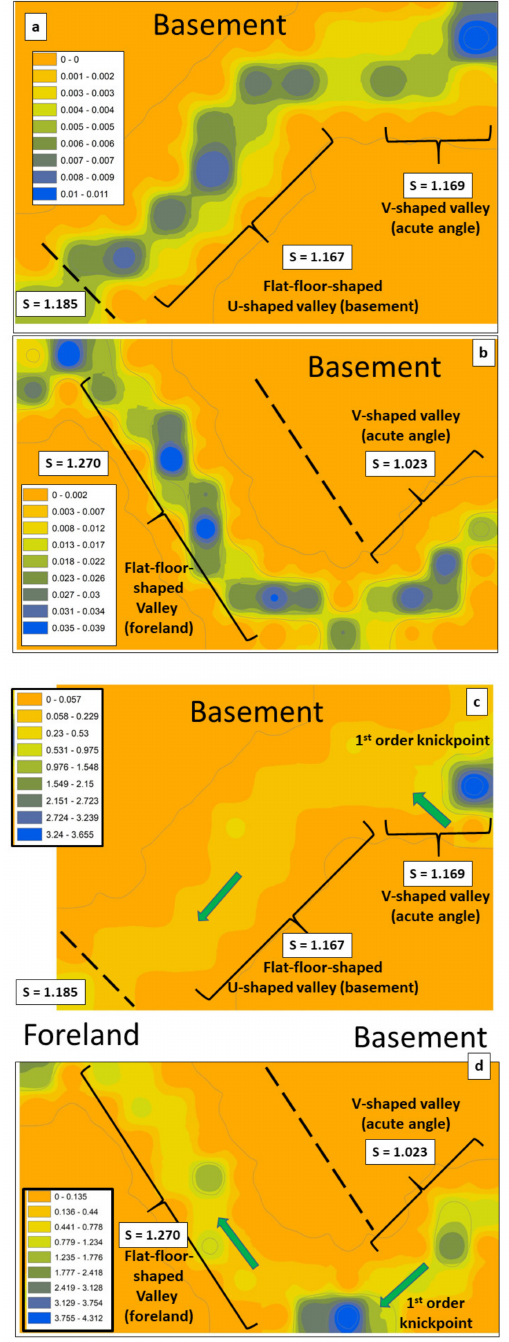
Figure 12. Density of hydrological systems per km 2 and the ratio of channel to floodplain. The sinuosity is given in white rectangular boxes, the cross-sectional shape of the valley is referred to alongside the talweg and the basement—foreland boundary is marked by the ruled boldface line striking NW-SE. The intensity is given by a color key with blue colors expressing the maximum. ( a ) Color composite map of the density of channels of the lower reaches of the VLG-Type. ( b ) Color composite map of the density of channels of the lower reaches of the LGG-Type. ( c ) Ratio of channel/floodplain of the lower reaches of the VLG-Type. ( d ) Ratio of channel/floodplain of the lower reaches of the